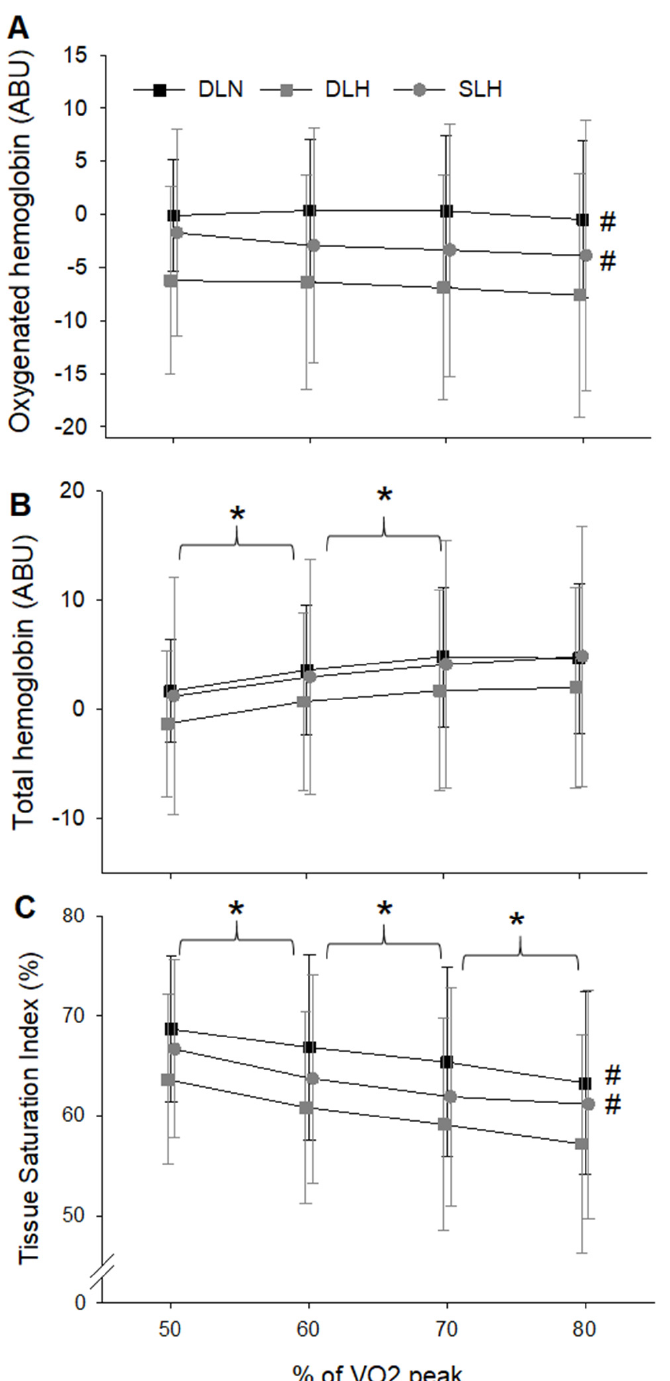
Figure 3. Changes in oxygenated hemoglobin ( A ), total hemoglobin ( B ) and TSI ( C ) across cycling condition and work rate. With regards to the main effect of condition, # indicates the significant reduction in both oxygenated hemoglobin and TSI during DLH compared to DLN ( p ≤ 0.008) and SLH ( p ≤ 0.01). Total hemoglobin was not significantly different across conditions ( p = 0.458). With regards to the main effect of intensity, * indicates the significant change in total hemoglobin and tissue saturation with exercise intensity. TSI% decreased with each increase in work rate ( p ≤ 0.011). DLN = Double-Leg Normoxia; DLH = Double-Leg Hypoxia; SLH = Sigle-Leg Hypoxia.